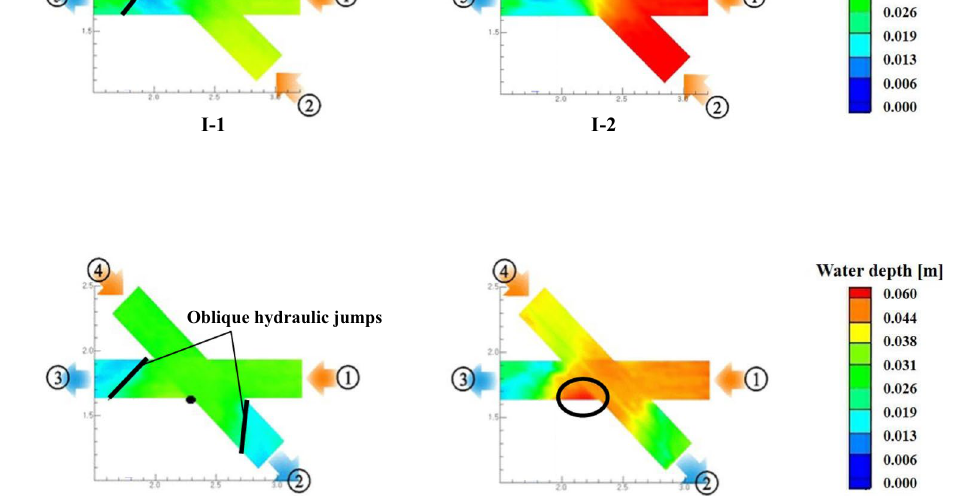
Fig. 7 Spatial variation of water depth around the confluence: Case I